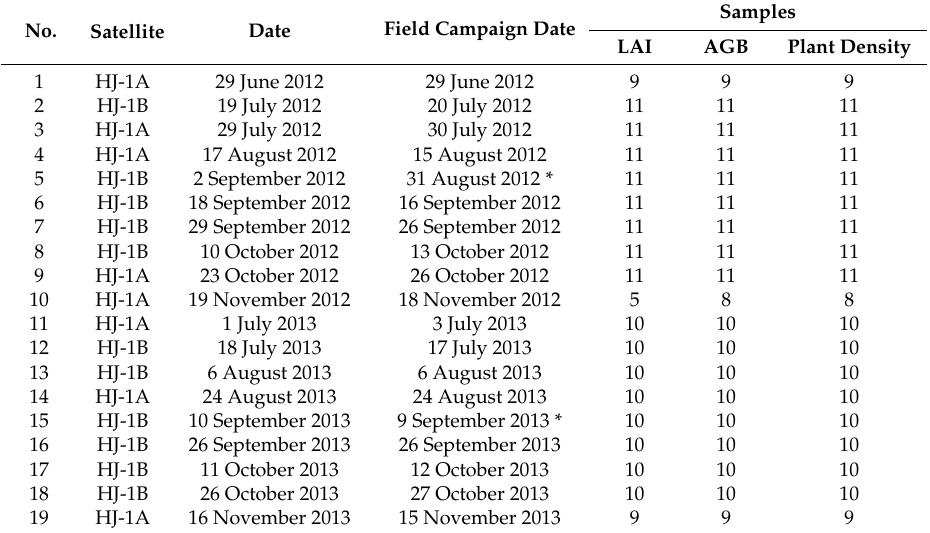
* The heading stage of single-cropped rice (SCR) according to the field campaign. LAI: leaf area index; AGB: aboveground biomass.